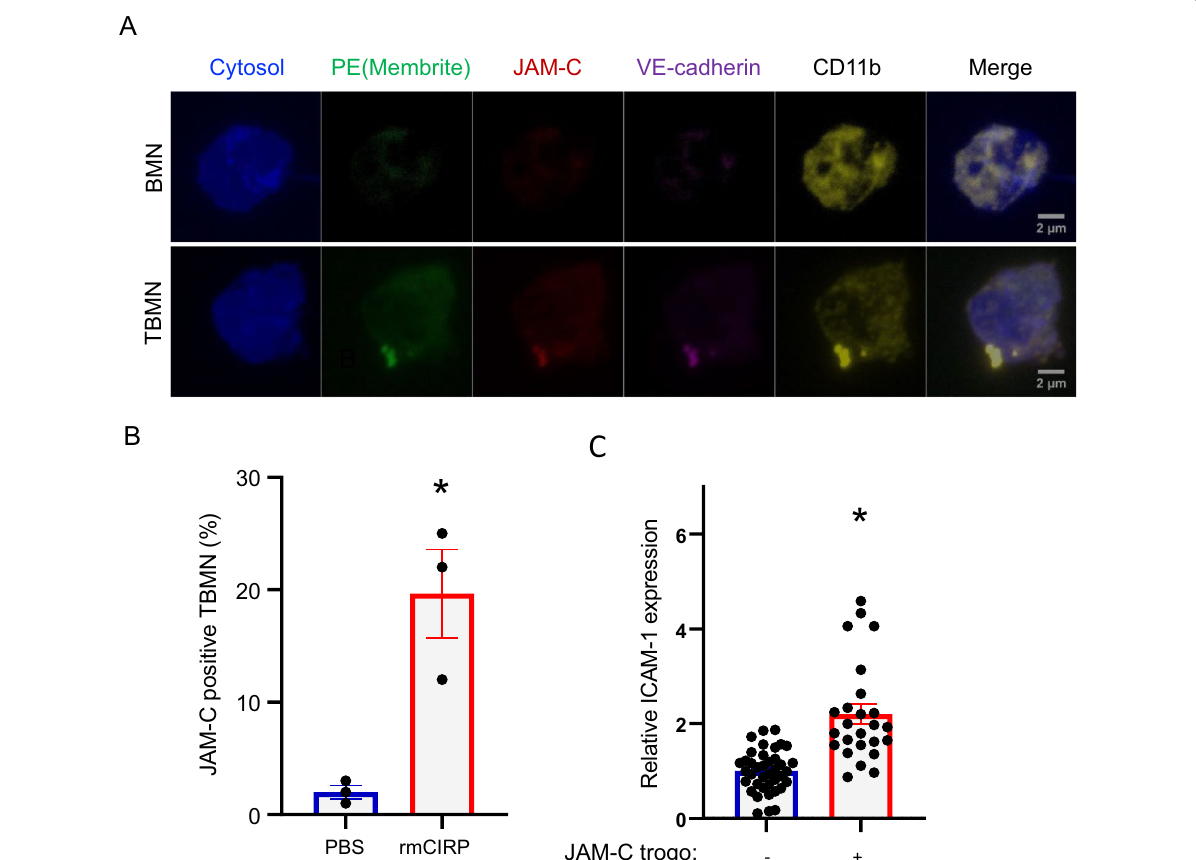
Fig. 5 eCIRP induces neutrophils to acquire JAM-C and VE-cadherin from endothelial cells and become pro-inflammatory. A The neutrophils trans-migrated through the endothelial cell layer on the transwell membrane (TBMN) and freshly isolated neutrophils (BMN) were further analyzed by immunostaining with antibodies to anti-JAM-C (red color), anti-VE-cadherin (magenta color), and anti-CD11b (yellow color). The neutrophils stained with antibodies were mounted on the glass slide and images were acquired with Zeiss LSM900 Airyscan 2 mode. The neutrophils were pre-stained with Celltrace Violet dye and shown in blue color in the pictures and endothelial cells were stained with PE (membrite) shown in green color prior to the assay. The arrow in the merged panel indicates co-localization of the signals. Scale bar, 2 µm. B The trans-migrated neutrophils (TBMN) stained as in the A were observed individually under the confocal microscope. JAM-C-positive TBMN treated with eCIRP were compared to the PBS control in the TEM assay. C The ICAM-1 expression level was observed by confocal microscopy. The trans-migrated neutrophils were collected and stained with anti-JAM-C antibody and anti-ICAM-1 antibody and the cells were individually imaged. The expression level of ICAM-1 in JAM-C positive neutrophils were compared to the level of ICAM-1 in JAM-C negative neutrophils. Data represented as mean unpaired, two-tailed student’s t